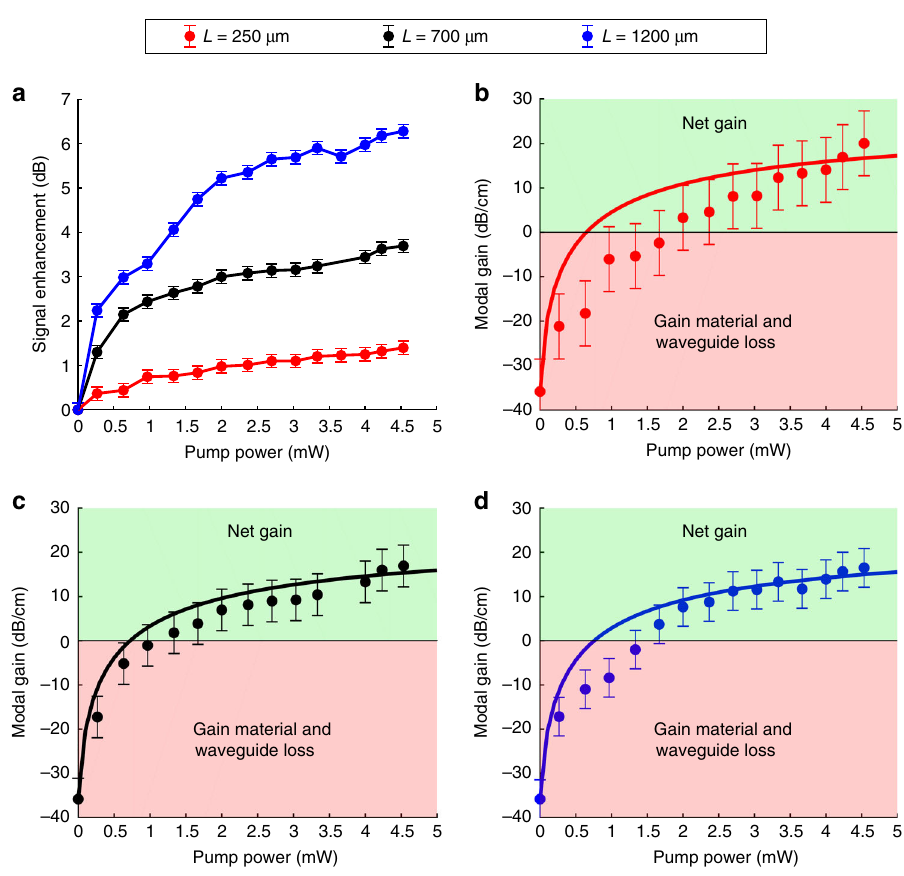
Fig. 6 Gain characterization of the hybrid slot waveguides. a Measured signal enhancements produced by the 250, 700, and 1200 μ m long Er:Al 2 O 3 – Si 3 N 4 hybrid slot waveguides; Calculated (solid points) and simulated (solid line) modal gain as a function of the injected pump power in b the 250 μ m long; c the 700 μ m long, and d the 1200 μ m long Er:Al 2 O 3 – Si 3 N 4 hybrid slot waveguides for a − 33 dBm ( ≡ 0.5 μ W) input signal beam. In a , the measurement level accuracy is ±0.15 dB. In b – d , the modal gain of each waveguide (including the error level) has been calculated according to Eqs. (1) and (2) (see Methods), and the regions for the net modal gain and loss are shown in green and red,